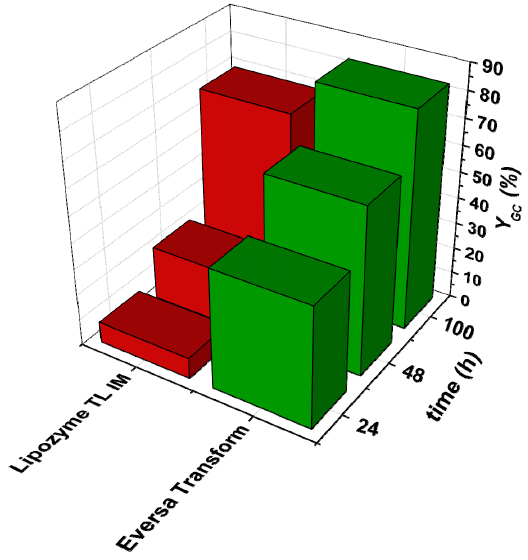
Figure 2. Comparison of the use of the Eversa Transform and Lipozyme TL IM for the reaction between glycerol with ethylene carbonate. Reaction conditions: closed system; T = 60 ◦ C; DMC:Gly = 3:1; amount of enzyme: 3% v / v ; solvent: tert-butanol (30% v / v ) agitation speed: 400 rpm.